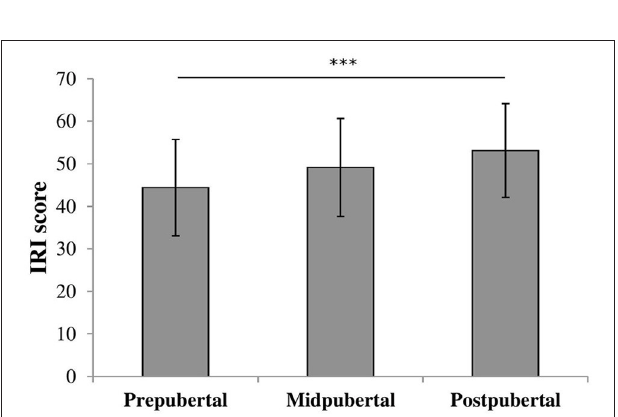
FIGURE 3 | Bars shown represent total IRI score per pubertal group, error bars show the standard deviation from the mean. Data showed a main effect for pubertal group. *** p =